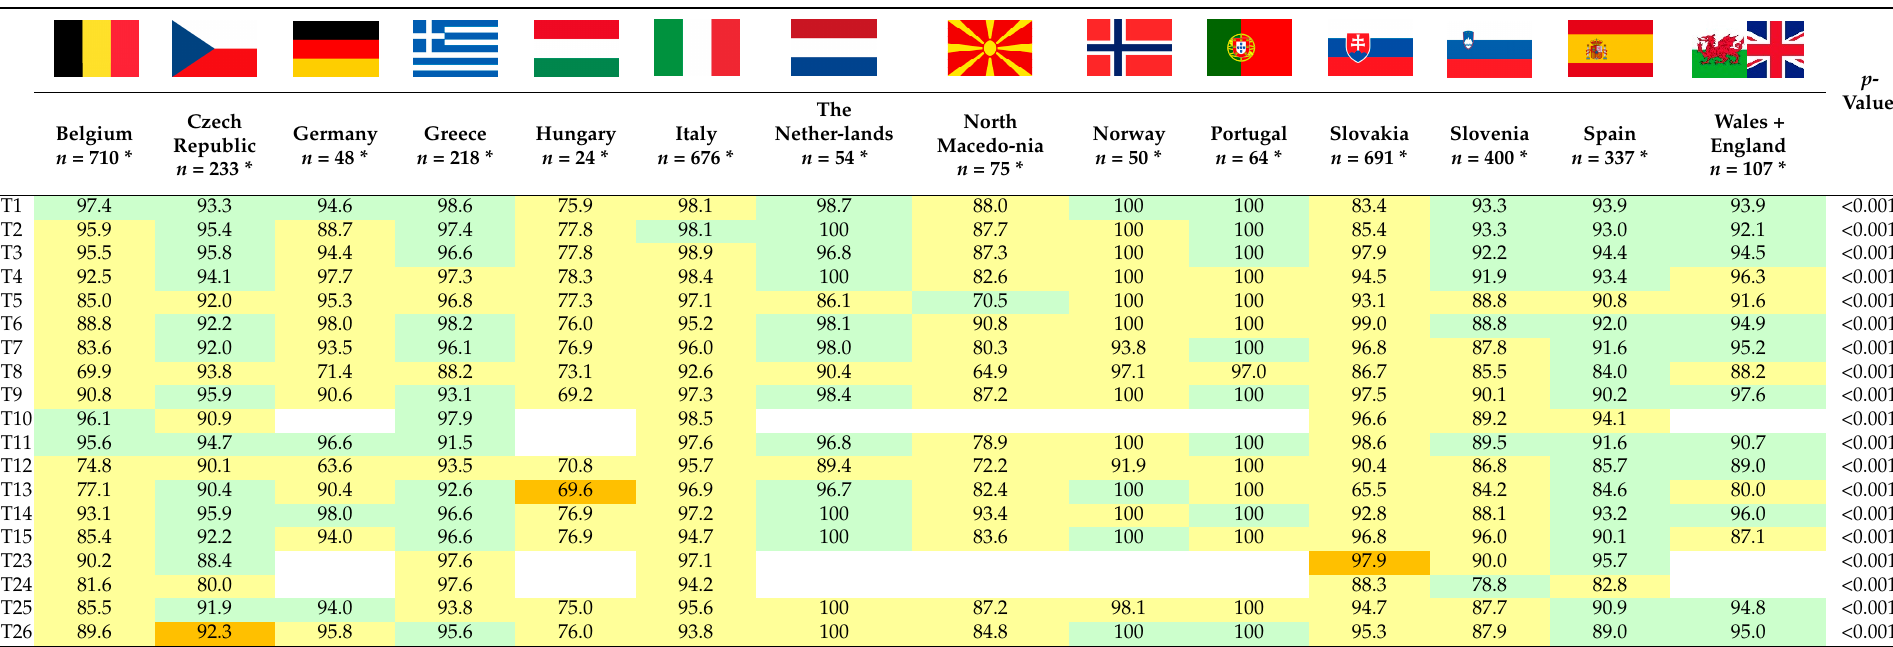
Table 4 . Percentages of healthcare professionals considering 26 tasks in seven $ pharmaceutical care domains to be nurses’ tasks in order to obtain best quality of care and patient outcomes, split up for 14 countries.